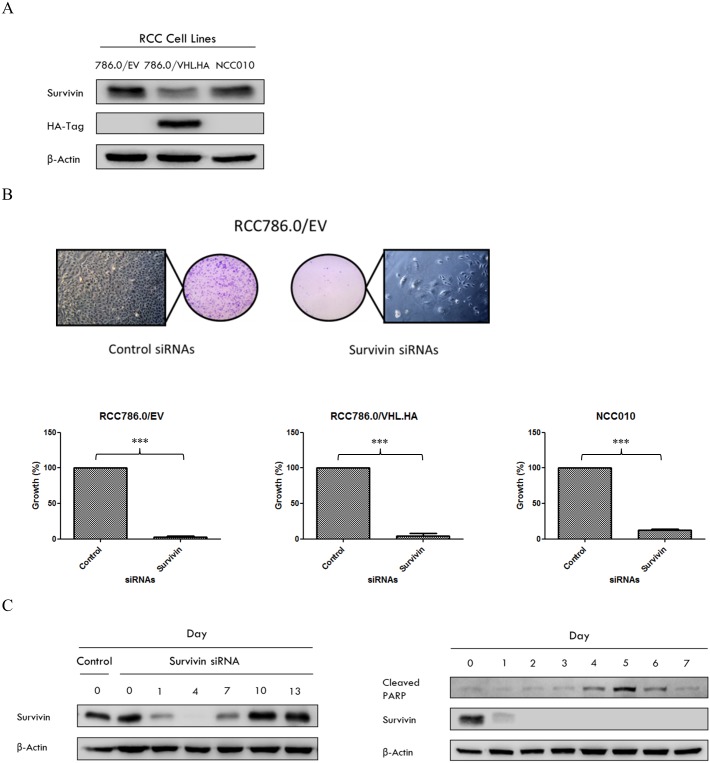
(A) Immunoblots of whole cell lysates of RCC786.0/EV, RCC786.0/VHL.HA and NCC010. β-actin is the loading control. HA-tag indicates the presence of the VHL transgene. (B) The effect of gene silencing on the proliferation of these cells was assessed by clonogenic survival assay. Visible and discrete colonies of transfected RCC786.0/EV were counted at the end of 10–14 days (100X magnification). The growth of RCC786.0/EV, RCC786.0/VHL.HA and NCC010 cells post-transfection are depicted and expressed as a % of the control. *** p<0.001 from corresponding control. (C) The expression of survivin in RCC cells transfected with survivin siRNAs was monitored from Day 0 to Day 13. The degradation of survivin siRNAs started after day 4 and the re-expression of survivin was observed from day 7 within the cellular environment. The expression of cleaved PARP, a marker of apoptosis in RCC786.0/EV cells following survivin siRNA-induced gene silencing was time dependent. Cleaved PARP appears on Day 4, approximately 48 h after expression of the survivin protein was inhibited on Day 2. There is a difference in the expression of survivin at Day 7 of the siRNA transfected cells in Fig 1C (left and right hand panels). This is attributed to the slight difference in transfection efficiencies across independent batches of transfected cells.